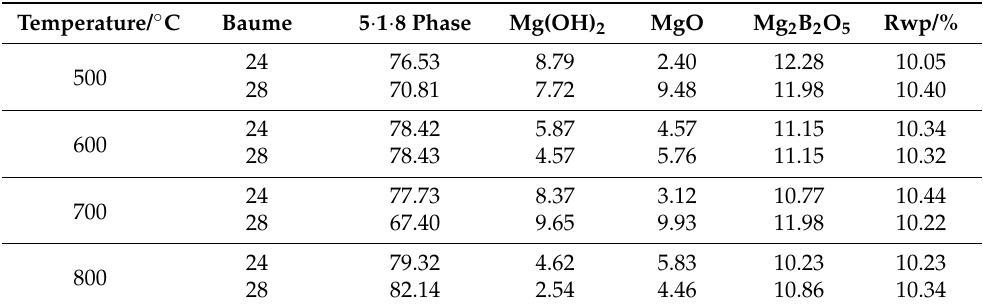
Figure 11. X-ray diffractograms of the MOC paste at different Baume and different calcination temperature of magnesium residue for 28 d: ( a ) 24 Baume ( b ) 28 Baume. Table 5. The phase and their quantities in MOC with different Baume and different calcination temperature of magnesium residue for 28